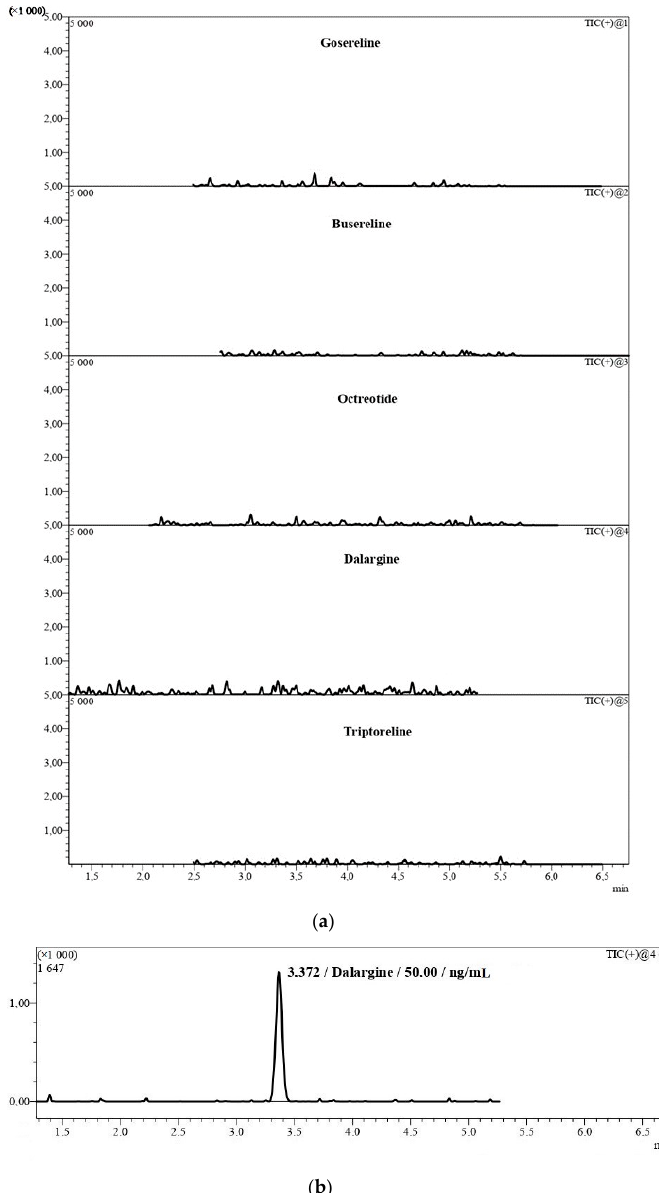
Figure 1. The chromatograms of ( a ) blank plasma samples and ( b ) blank plasma samples with IS. The obtained values of the correlation coefficients ( R ) were considered valid ( ≥ 0.99).